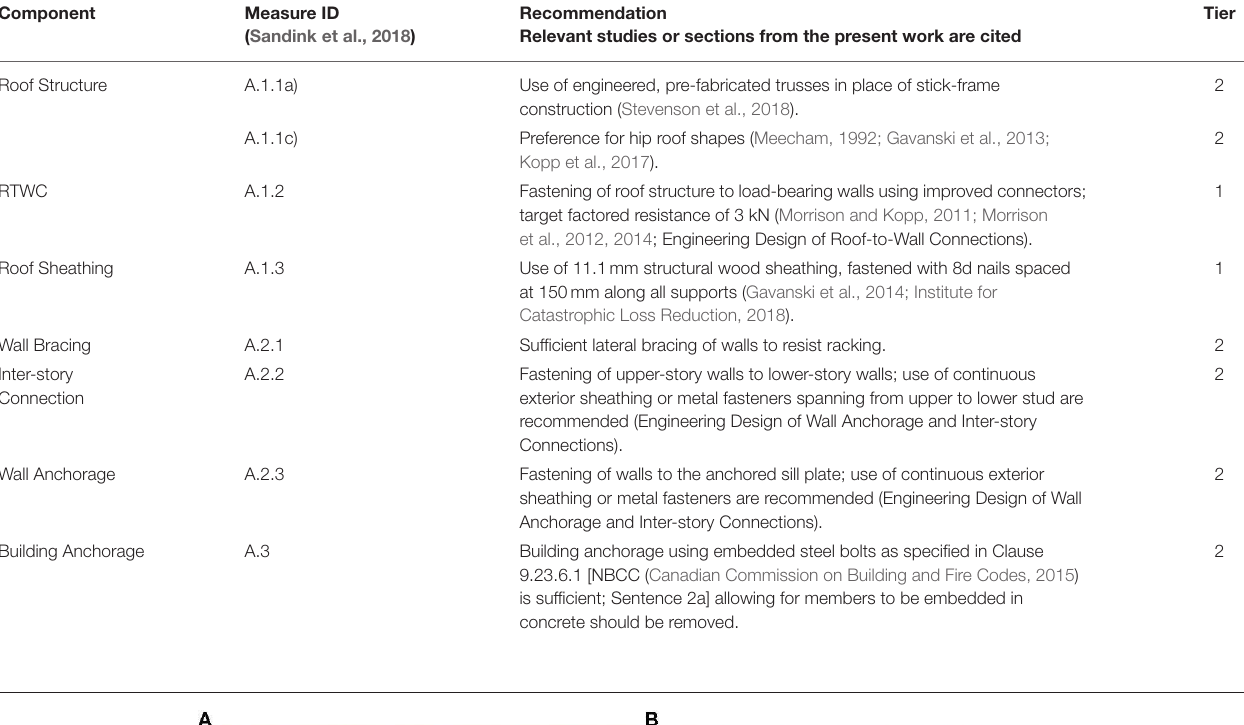
TABLE 7 | Summary of recommendations from Sandink et al. (2018) that are relevant to the present analyses.